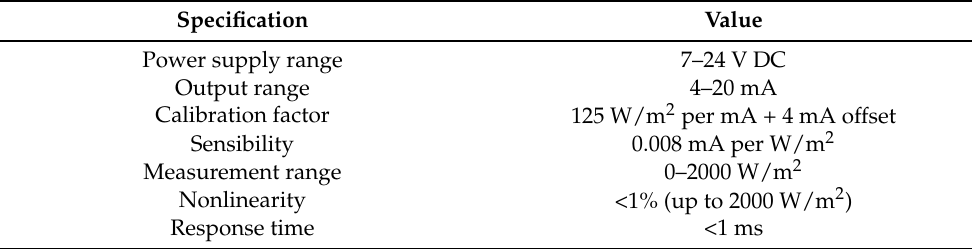
Table 4. Main specifications of the pyranometer SP-214 (Apogee Instruments, Inc., Logan, UT,